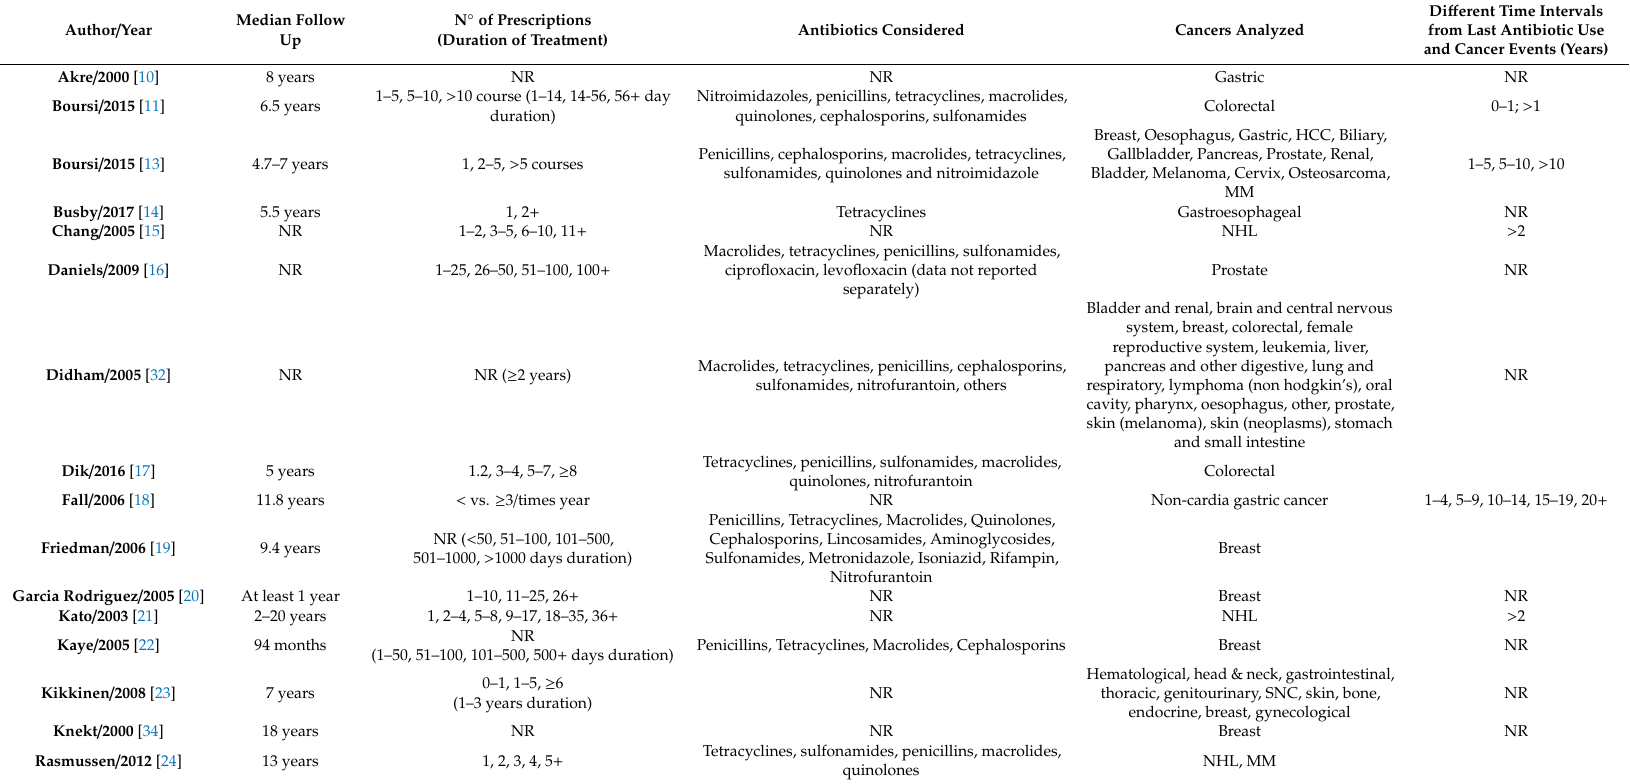
Table 2. Characteristics of included studies with antibiotics classes, cancers analyzed and